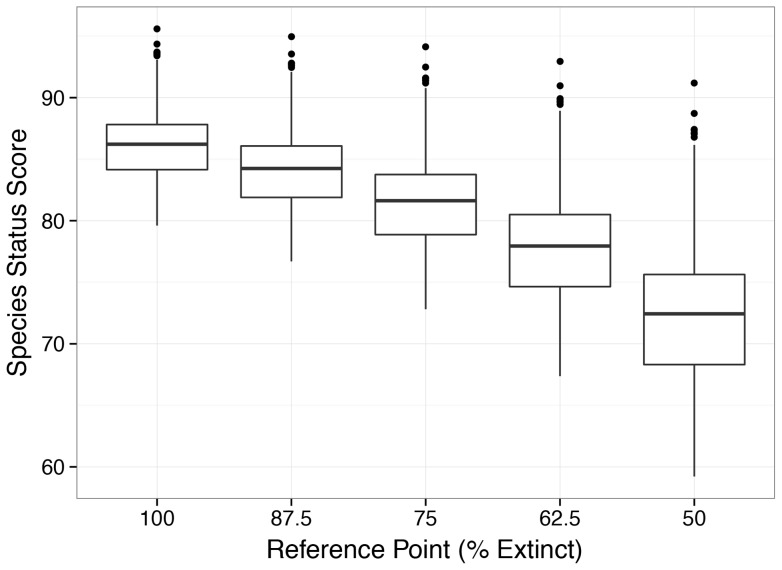
Distribution of species status scores by EEZ region when the lowest possible score was defined by different values of % of extinct species.The median value divides the box, which extends from the first (25%) to the third (75%) quartiles of the distribution. Whiskers extend to the last point within this interquartile range * 1.5 and dots indicate outliers.